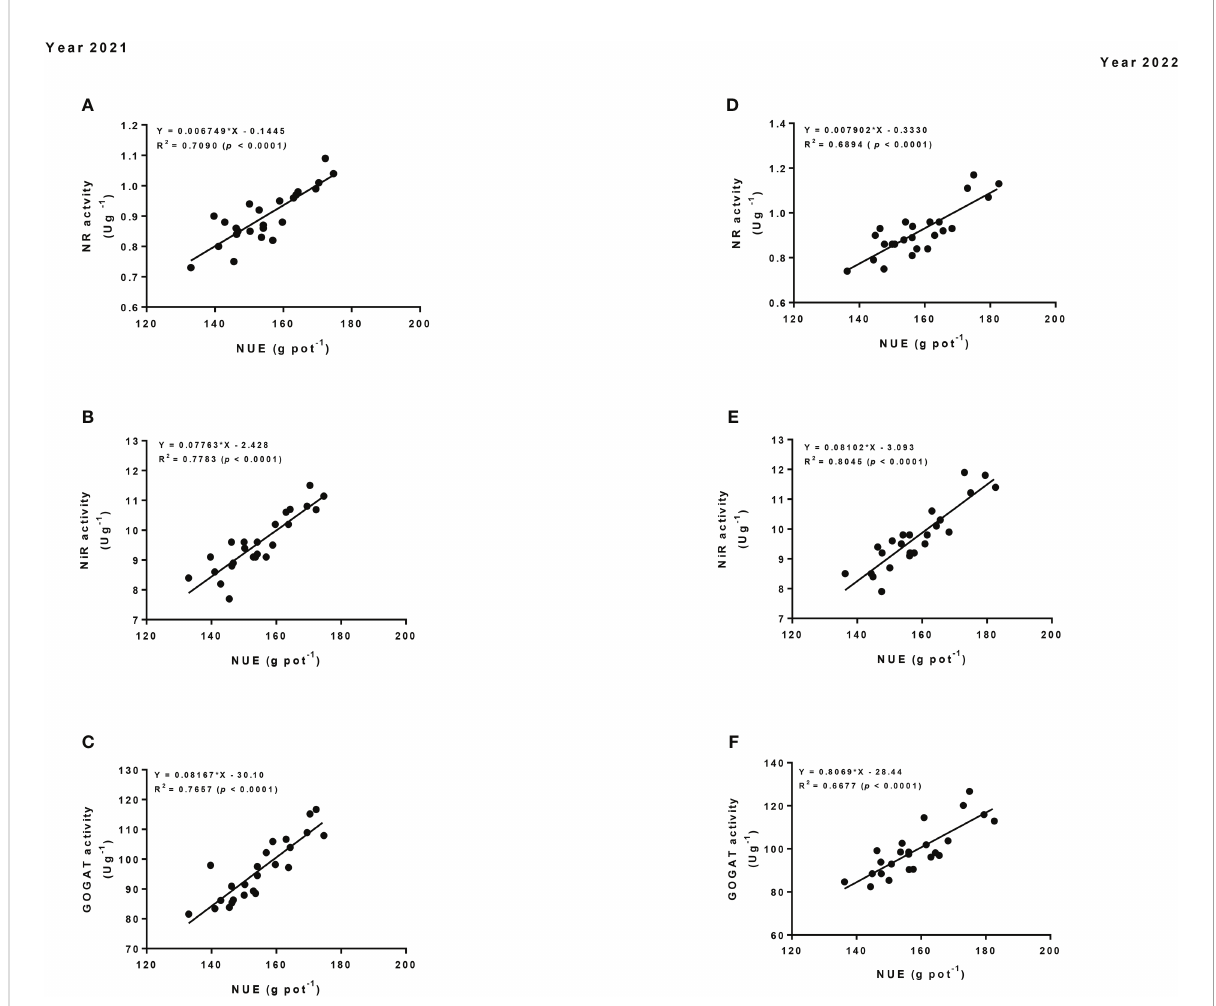
FIGURE 8 Regression analysis of nitrogen use ef fi ciency (NUE) for maize crop with nitrogen assimilatory enzymes (i.e., NR (A, D) , NiR (B, E) , and GOGAT activity (C, F) ) in 2021 and